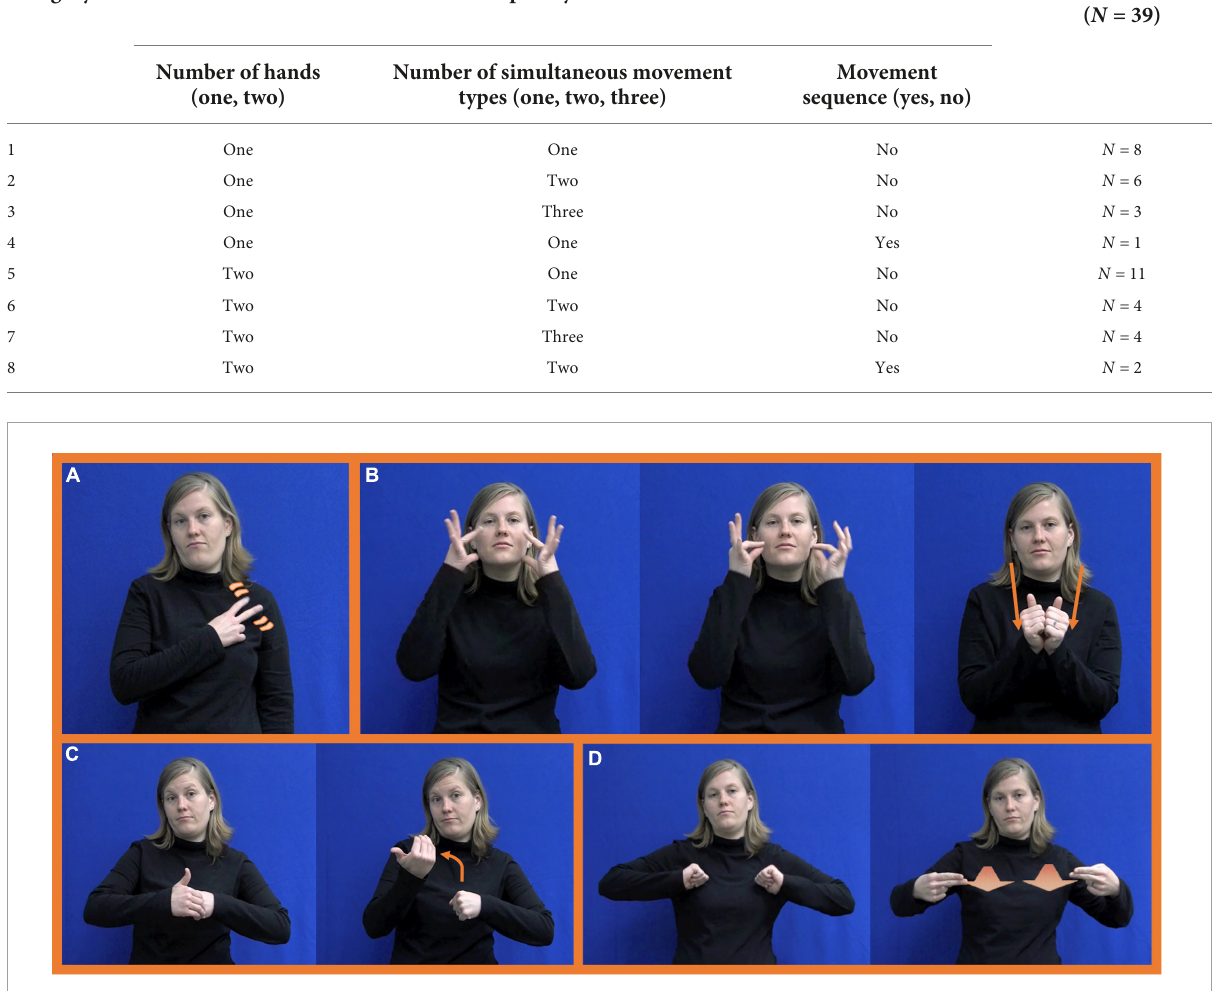
FIGURE3 Still pictures of example pseudosign stimuli. (A) One hand, one movement type, no movement sequence (category 1). (B) Two hands, two simultaneous movement types, movement sequence (category 8). (C) Two hands, two movement types, no movement sequence (category 6). (D) Two hands, three simultaneous movement types, no movement sequence (category